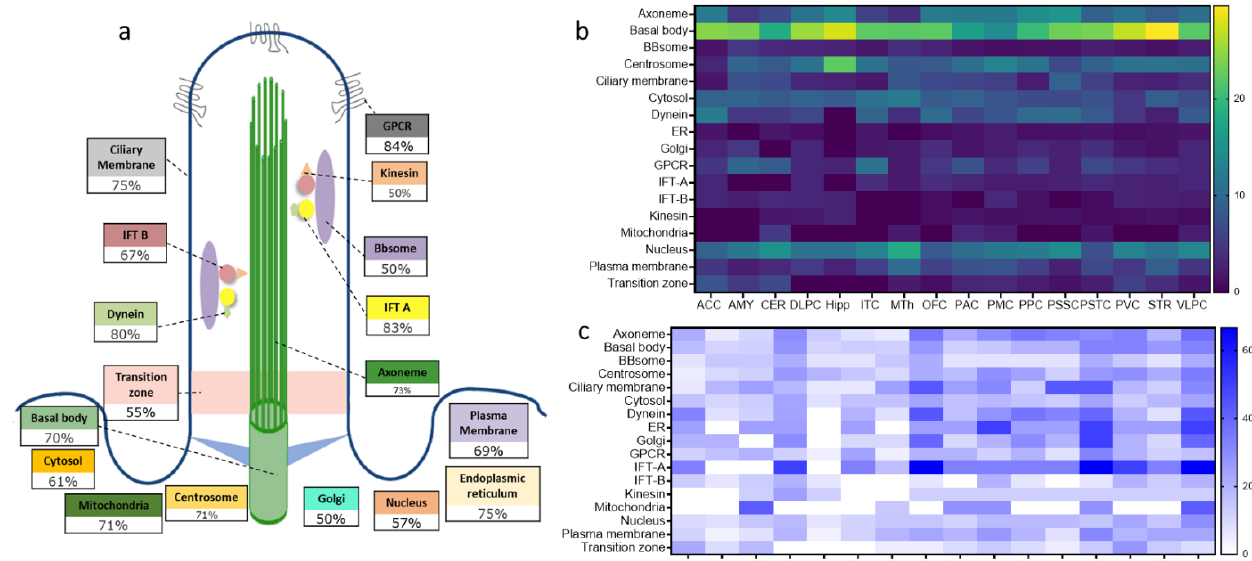
Figure 4. Sub-structural organization of cilia DEGAs genes. ( a ) Percentages of the total DEGAs genes in each of the cilia sub-structural compartments as proportions to the total cilia genes in each sub-structural compartments. ( b ) Heatmap of cilia sub-structural DEGAs presented as proportions to the total cilia transcripts in 16 brain regions. Yellow indicates a high percentage of DEGAs genes, and dark blue indicates no DEGAs genes in a given brain region. ( c ) Heatmap of the cilia sub-structural DEGAs presented as proportions to the total corresponding sub-structural transcripts in 16 brain regions. Dark blue indicates a high percentage of upregulated genes, and white indicates no DEGAs in a given brain region.